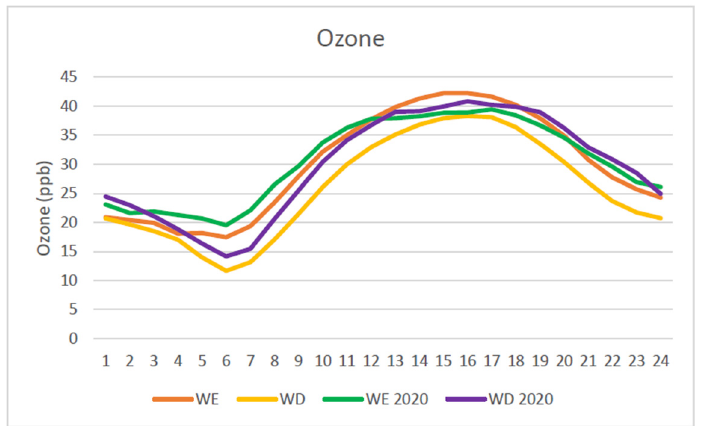
Figure 10. Ground-level ozone (O 3 ) for the average period April to June 2010–2019 for weekends (WE) and weekdays (WD) and for April to June 2020 (WE 2020, WD 2020) at Toronto West.